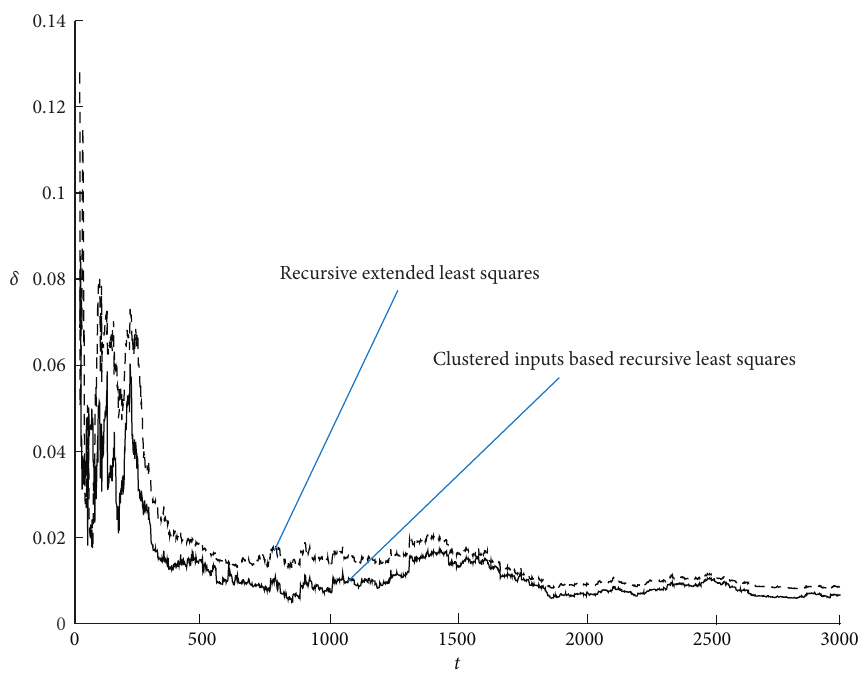
Figure 8: The parameter estimation error δ versus time t for σ 2 � 0 . 10 2 .